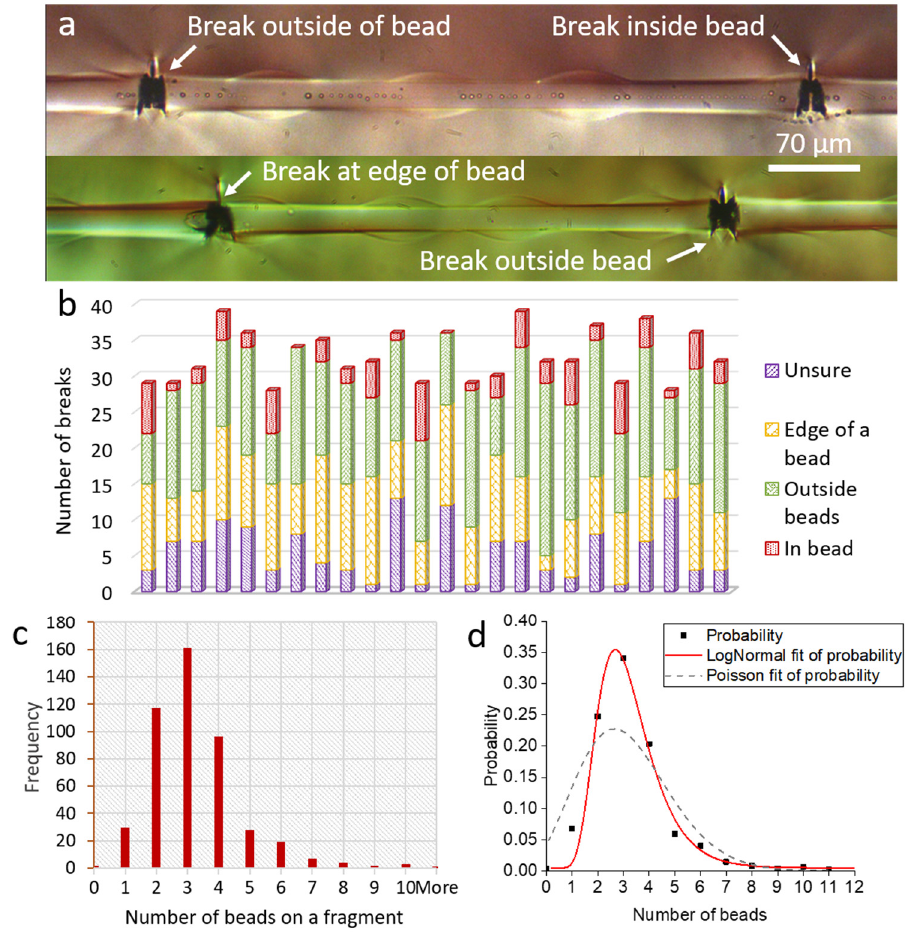
Figure 8. Analysis of beaded fibre fragments at saturation . ( a ) Beaded fibres after fragmentation under polarised light showing fragments with three whole beads (top) and four whole beads (bottom). Breaks are seen in between beads, at the edge of a bead and inside a bead after fragmentation test. ( b ) Position of breaks in beaded fibre samples. ( c ) Number of beads on each fragment. ( d ) Lognormal fit to data from ( c ), with mean of 3.05 and standard deviation of 0.36.